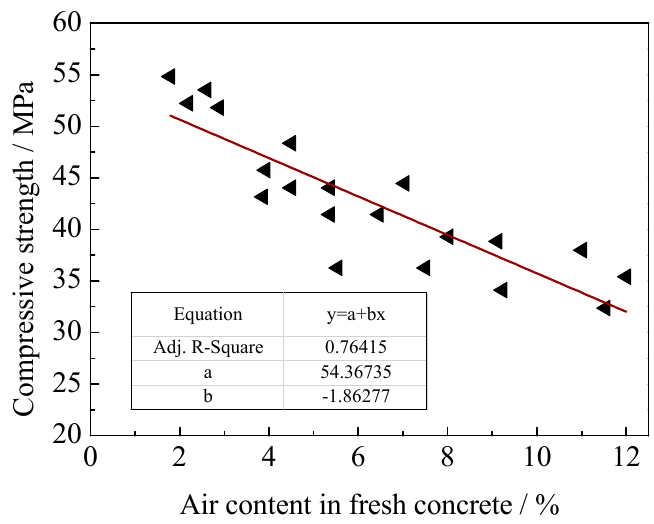
Figure 10. Effect of air content on the compressive strength of hardened concrete.